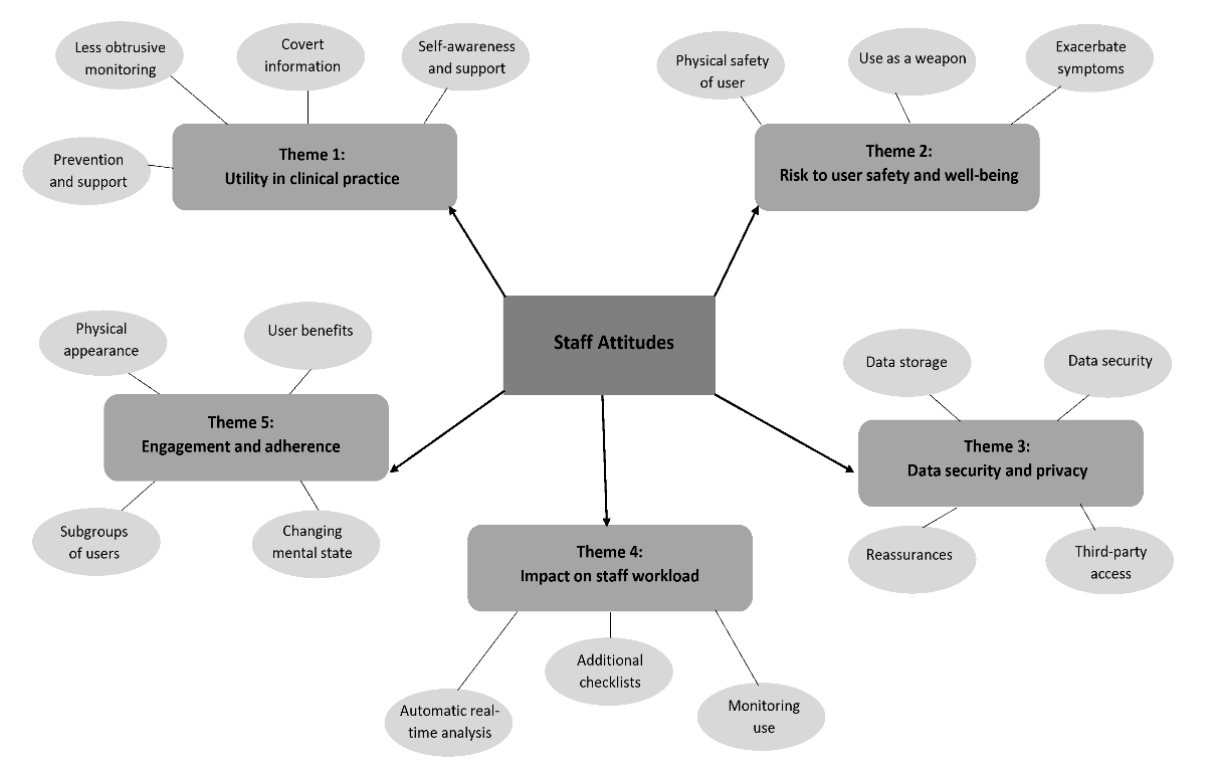
Figure 1. Themes and subthemes identified through thematic